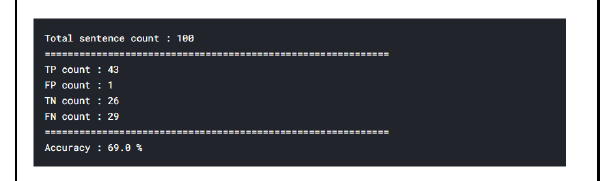
Fig 5.4 Output of Accuracy of Trigram model